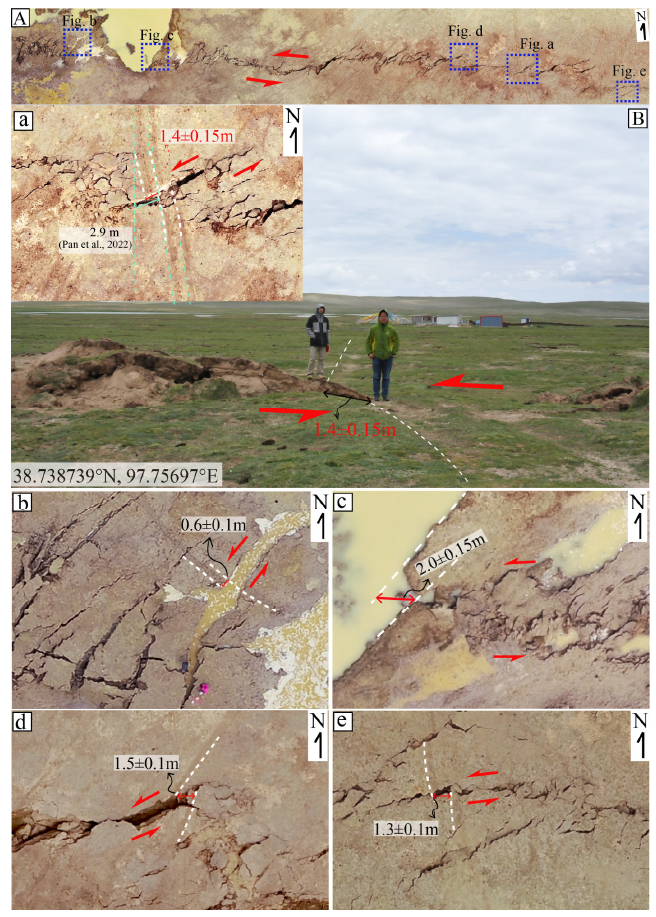
Figure 8. Orthophotos of co-seismic left-lateral strike-slip displacements on the South Eling Lake segment. ( A ) Index locations of offsets a – e ; ( a , B ): orthophoto and field photo of tire tracks dislocation; ( b ): left-lateral offset of a rut print; ( c ): left-laterally dislocated bank of a small lake; ( d , e ): left-lateral offsets of pathways on the grassland. The region of Figure 9A is 1 km to the east of the site of Figure 8e along the South Eling Lake segment. The continuous rut prints were offset by the main fault trace and multiple echelon sub-faults in the stepover zone. The sinistral offset of the rut prints was 0.7 ± 0.1 m (Figure 9a). The main fault displaced the tire tracks by 1.6 ± 0.1 m and the oblique-arranged sub-fault displaced the lower tire tracks by 0.4 ± 0.1 m (Figure 9B,c). The open cracks formed by the faults could reach up to 1.5 m wide in this area (Figure 9B), indicating the more intensive regional strain in the stepover zone along this segment of the rupture.